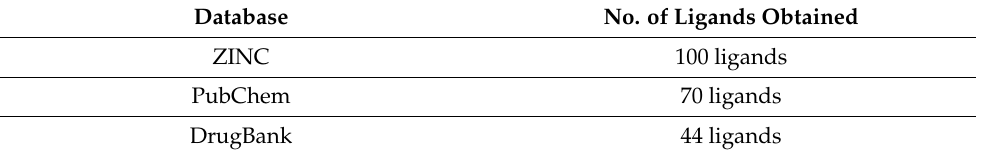
Table 3. Ligands obtained from different databases during ligand-based virtual screening.